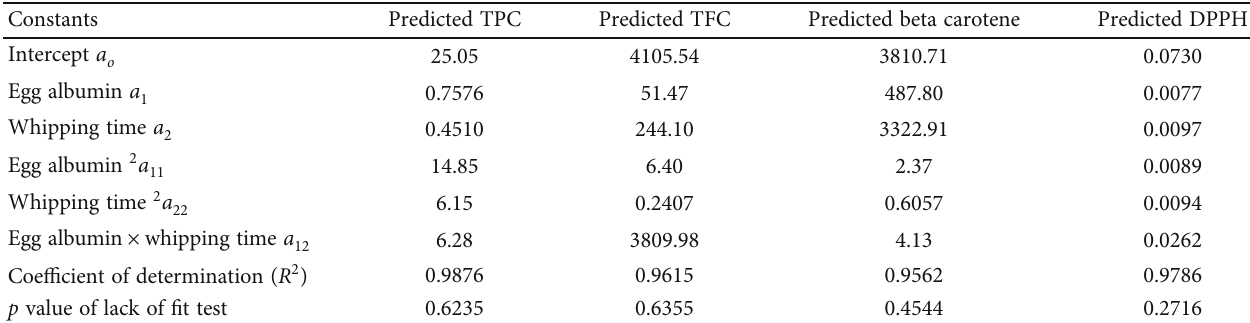
Table 6: Regression coe ffi cients, the coe ffi cient of determination ( R 2 ), and lack of fi t values for the second-order fi tted models corresponding responses, TPC (GAE/g), TFC (mg/100 g), beta carotene ( μ g/100g), and DPPH (%) with x whipping time